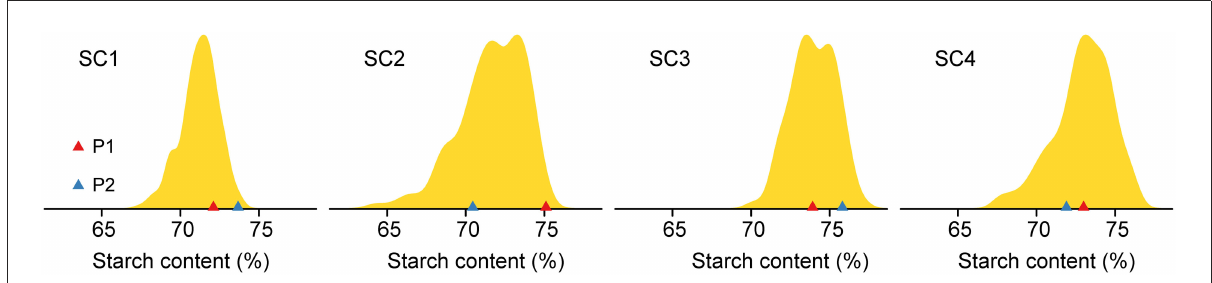
FIGURE1 Phenotypic variations in starch content (SC) in the four double-haploid (DH) populations. The x-axis shows the SC and the color triangle represents the parents.